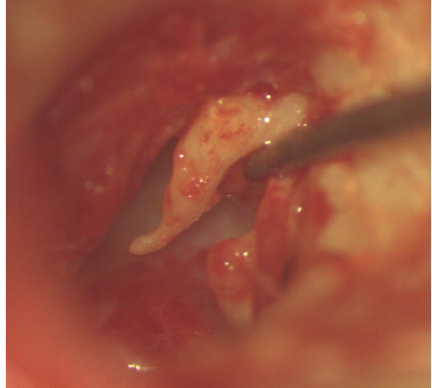
Figure 2: Tensor tympani tendon being cut during surgery.